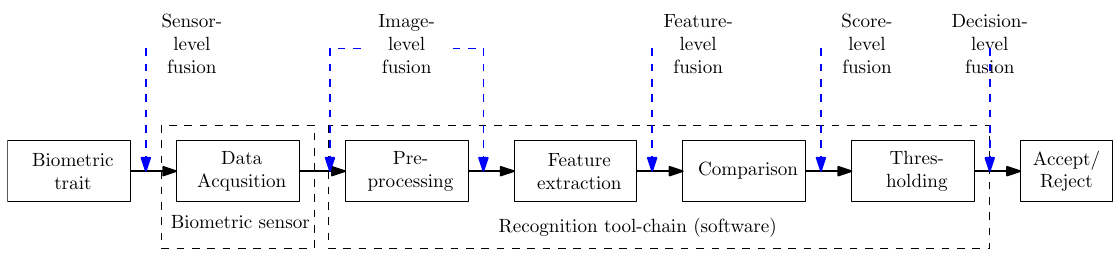
Figure 7. Biometric recognition tool-chain and different levels of biometric fusion.